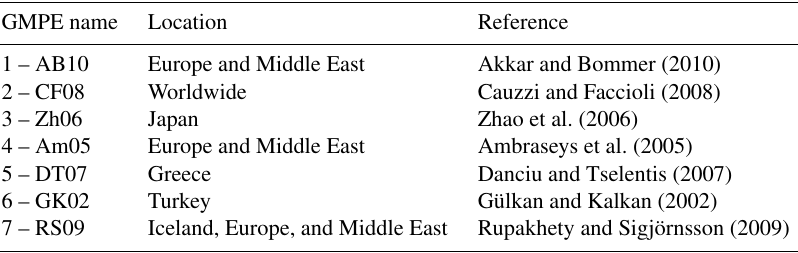
Table 2. List of GMPEs used in this